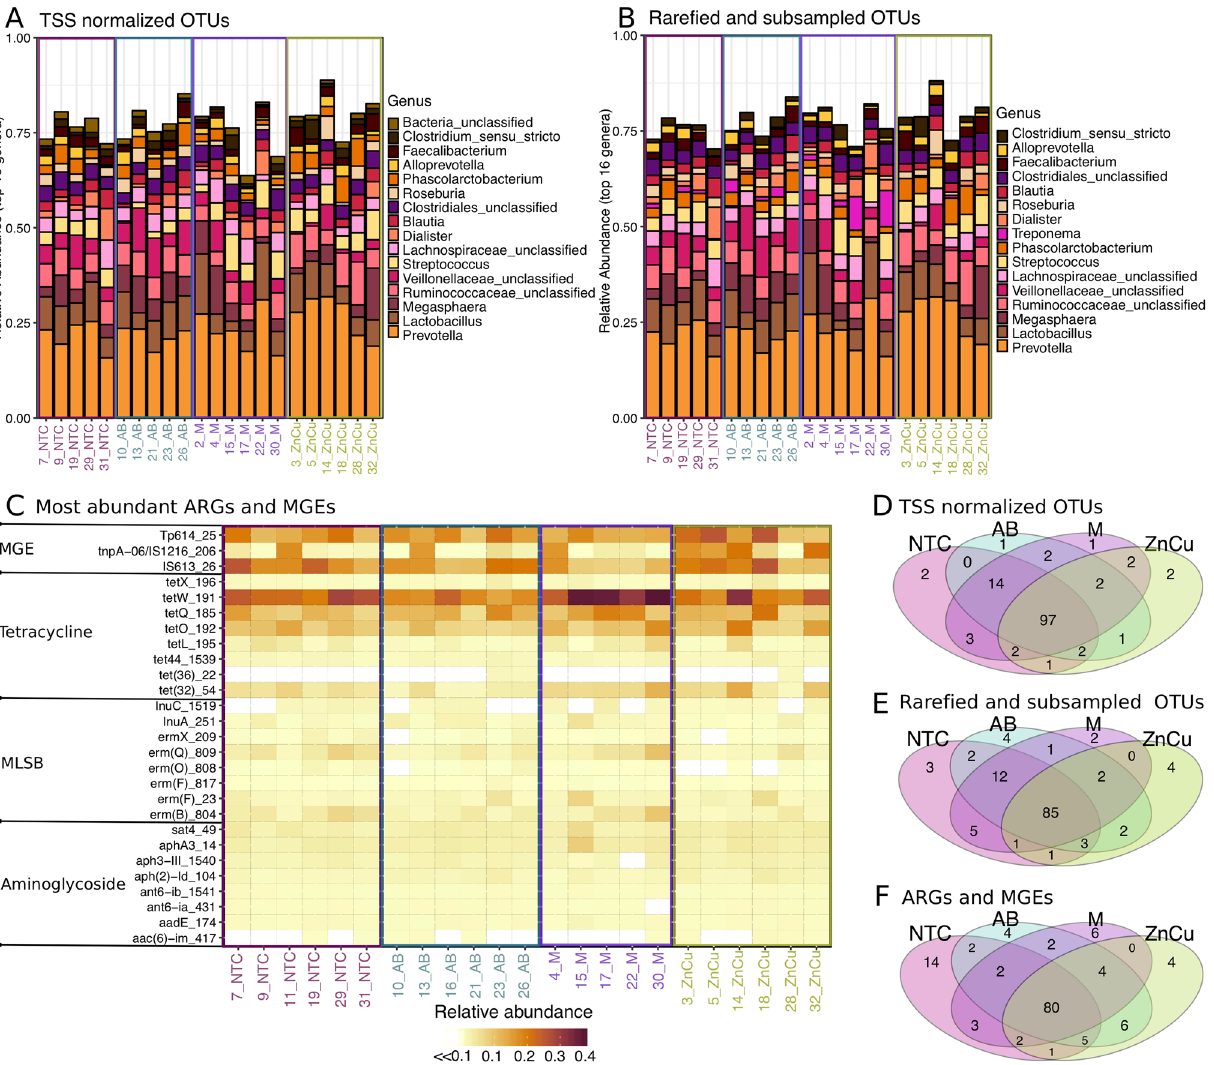
Figure 1. Comparison of the most abundant genera, ARGs and MGEs in different treatment groups. Samples on x-axis are grouped according to the treatments and color-coded. Sample names are as follows: NTC non- treatment control, AB carbadox (antibiotic), M mushroom powder, ZnCu zinc oxide and copper sulfate. The number in front of the group code denotes the number of the pen. ( A ) Stacked bar plot showing 16 most abundant genera in OTUs normalized using total sum scaling (TSS). ( B ) Stacked bar plot showing 16 most abundant genera in rarefied and subsampled OTUs. ( C ) Most abundant genes related to antibiotic resistance and mobile genetic elements (n = 27). Each row represents results of each primer set (assay) (Supplementary Table S1) displayed on the y-axis. Assays are grouped according to the antibiotic group which the target genes confer resistance. MLSB is abbreviation for Macrolide − Lincosamide − Streptogramin B resistance and MGE for mobile genetic elements. One sample from mushroom powder group was left out from the qPCR array analysis due to a technical error. ( D ) Venn diagram showing the OTUs that are shared between samples belonging into different treatment groups when TSS normalization was used. ( E ) Venn diagram showing the OTUs that are shared between samples belonging into different treatment groups when Rarefying and subsampling was used. ( F ) Venn diagram showing the ARGs and MGEs that are shared between samples belonging into different treatment